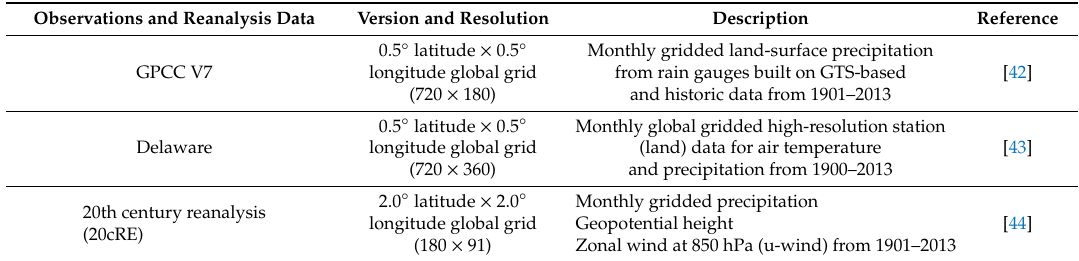
Table 1. Observations and reanalysis used in this